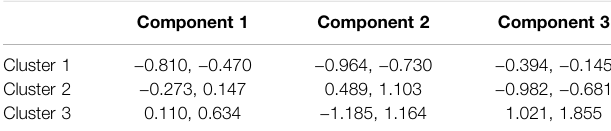
TABLE 5 | 20 – 80% principal component range table (sample 1).